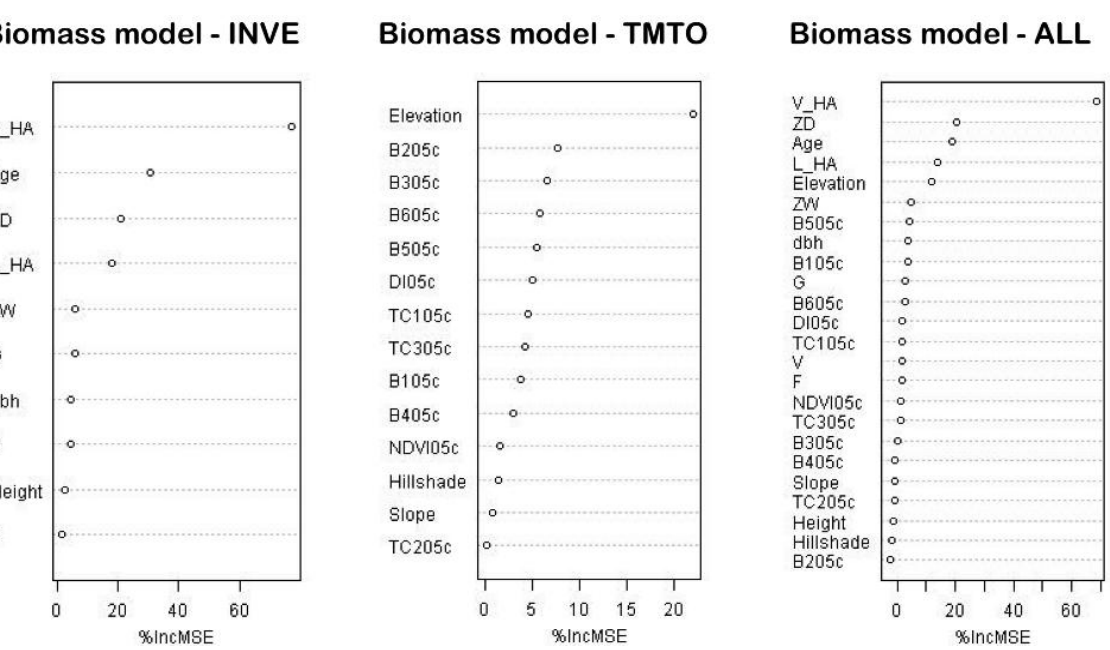
Figure 5. Predictor’s importance ranking for biomass prediction, based on INVE, TMTO and ALL models. Description of predictors: Landsat TM bands (B105c, B205c, B305c, B405c B505c, B605c), TC brightness (TC105c), TC greenness (TC205c), TC wetness (TC305c), Disturbance Index (DI05c), NDVI (NDVI05c), volume of trees per ha (V_HA), relative density (ZD), canopy cover (ZW), tree age (Age), tree height (Height), tree stem density (L_HA), tree form factor (F), growing stock for single tree (V) and stump surface at DBH